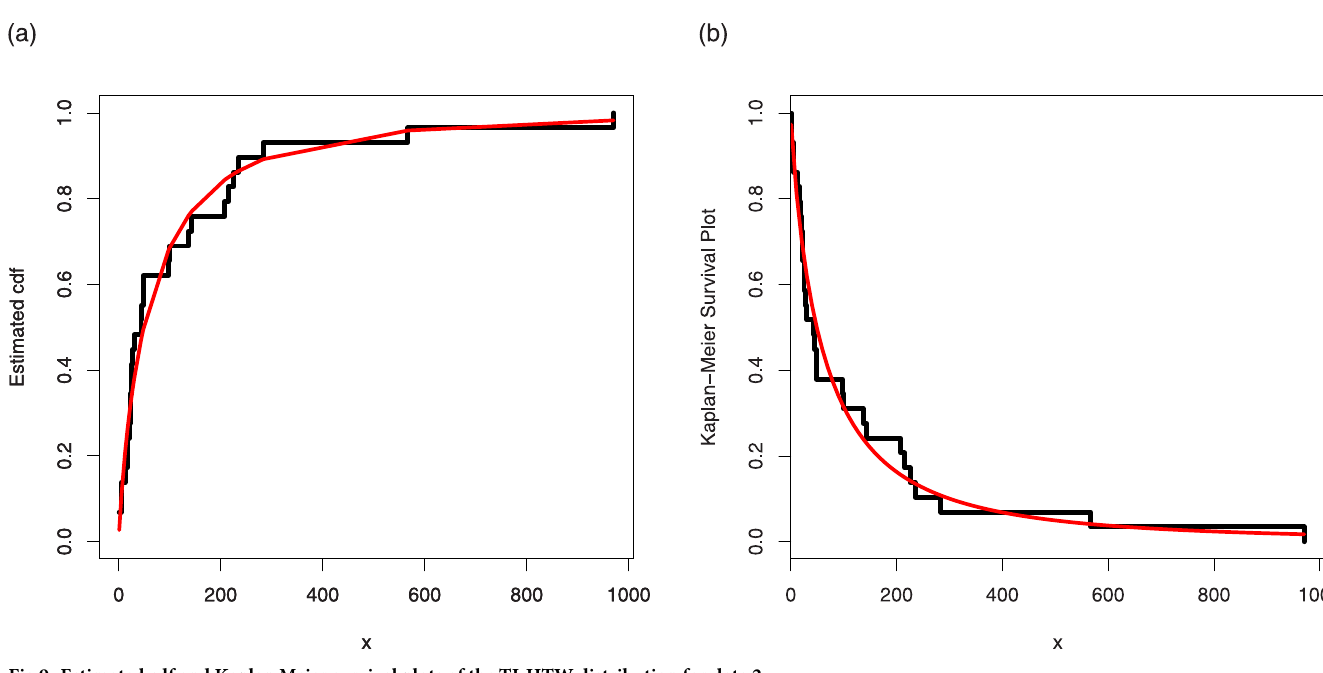
Fig 9. Estimated cdf and Kaplan Meier survival plots of the TI-HTW distribution for data 2.